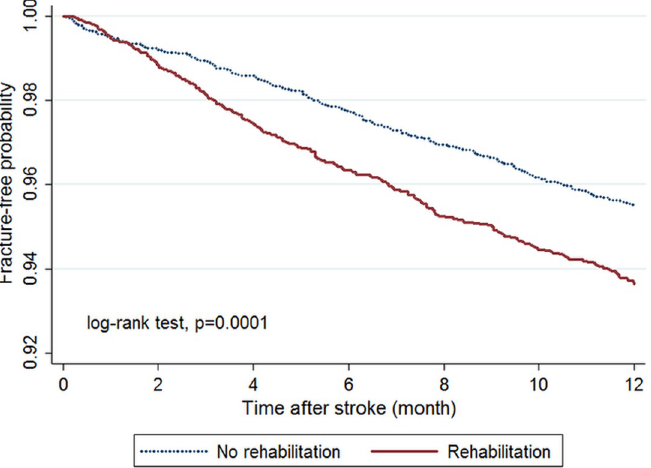
Fig 2. Kaplan–Meier curves showing estimated fracture-free proportions of patients with and without post-stroke rehabilitation.